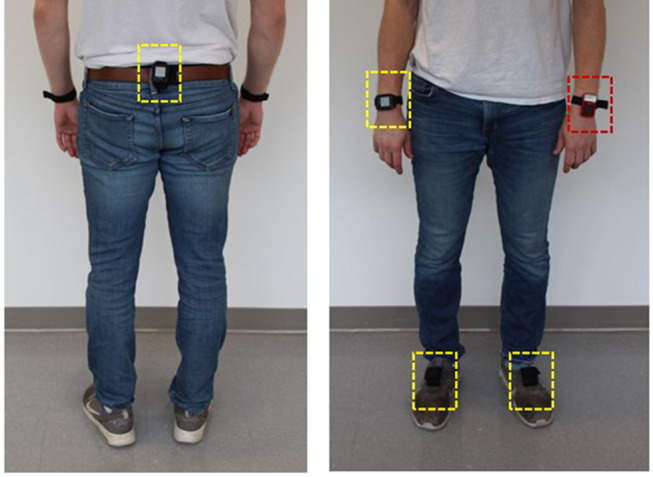
IMUs mounting location at feet, lower back and one wrist (dashed yellow line) and a voice recorder worn on the other wrist (dashed red line).